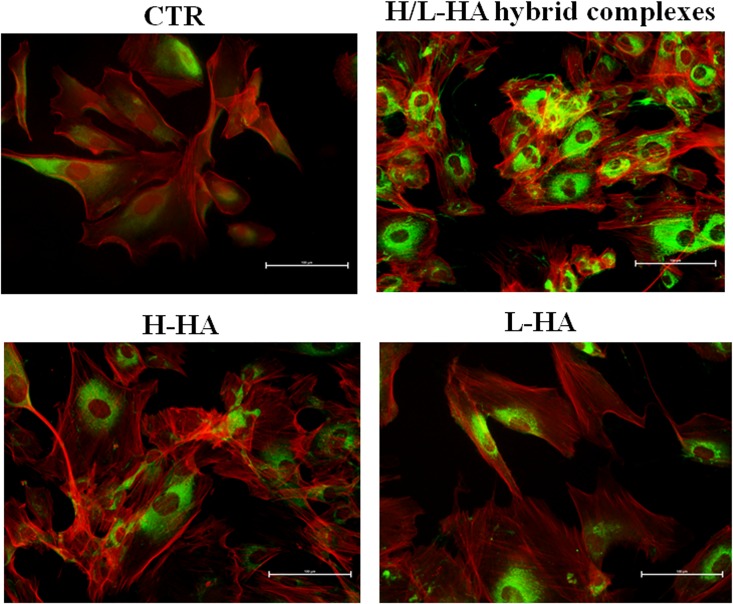
Keratinocytes-fibroblasts immunofluorescence pictures relative to COLIA1 expression in presence of H-HA, L-HA and H/L-HA complexes 0.16% (w/w) at 24h.Green: type I collagen, red: Cytoskeleton (Phalloidin).